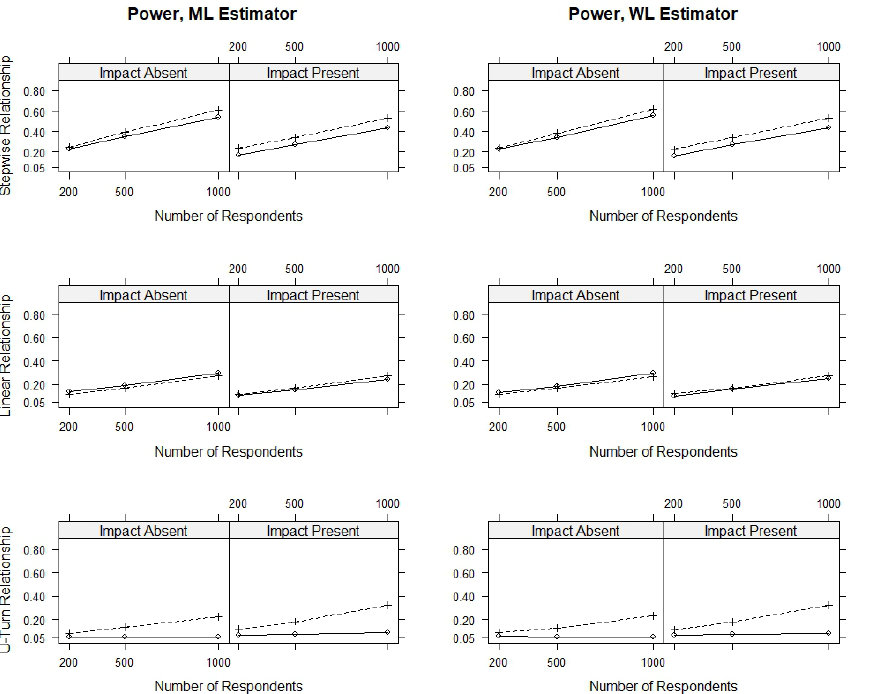
Figure A7. Power of two tests against balanced DIF in the β parameter for modules of 18 items. Only items suspected to be DIF-free are used for ability estimation. The unbroken line presents the results for the linear logistic regression test, the broken line presents the results for the score-based bootstrap test.